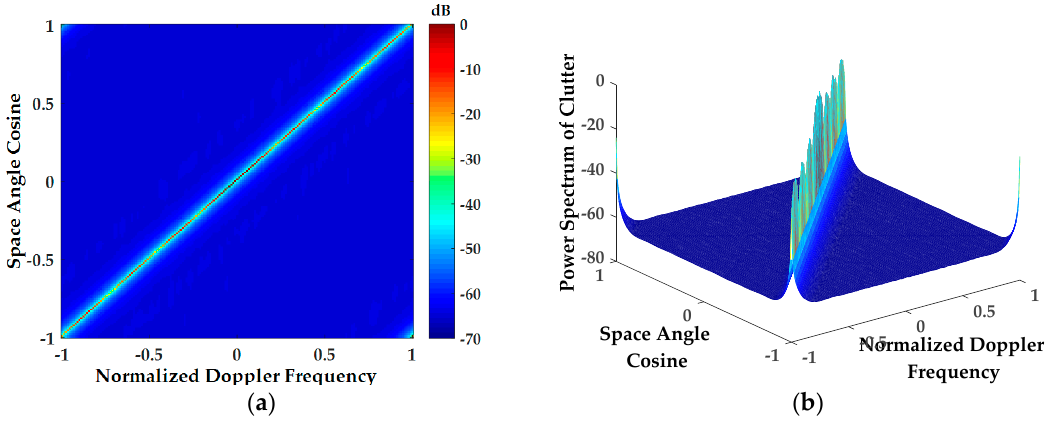
Figure 13. Space-time spectrum of ground clutter: ( a ) Two-dimensional space-time spectrum; ( b ) 3D space-time spectrum.